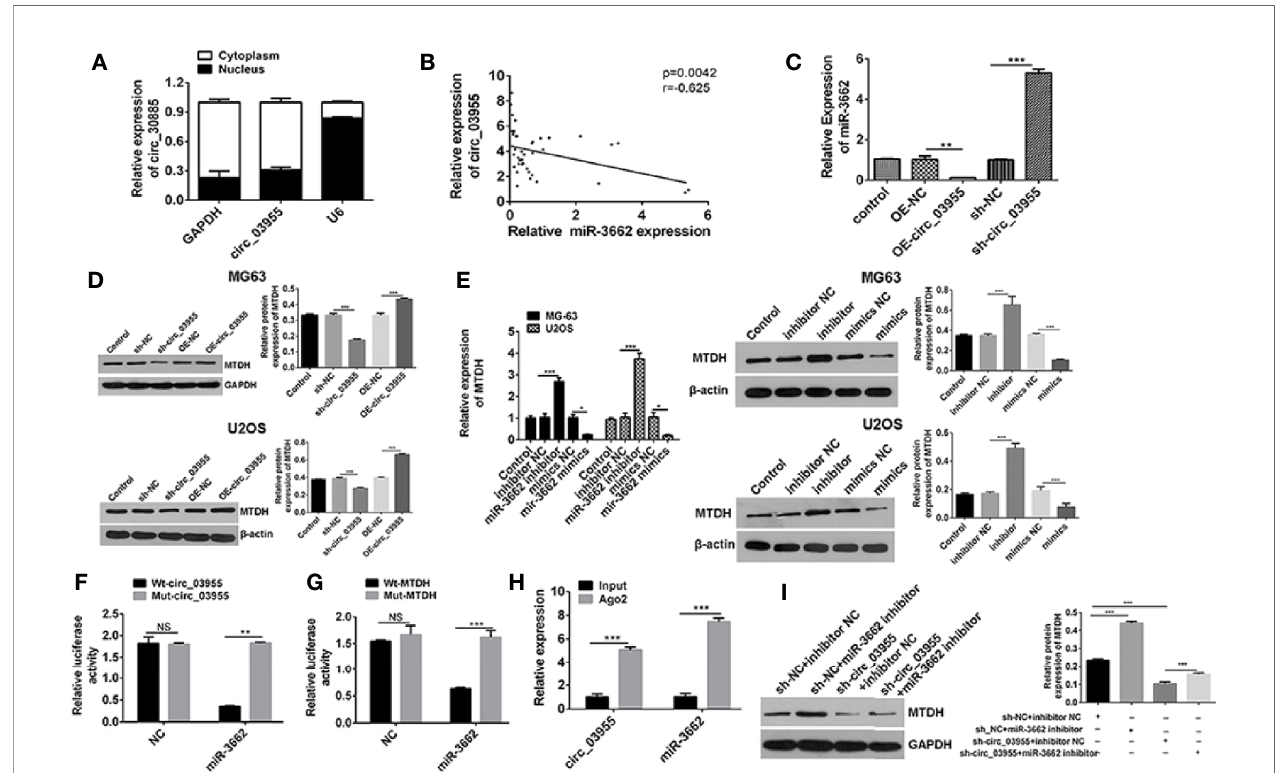
FIGURE 4 | Circ-03955 acts as a ceRNA by sponging miR-3662 and indirectly regulates MTDH expression. (A) The differential expression of circ-03955 in MG-63 cytoplasm and nucleus of osteosarcoma cells veri fi ed by qRT-PCR. (B) Analysis of the correlation between circ-03955 and miR-3662 expression in osteosarcoma. (C) qRT-PCR was used to detect the effect of OE-circ-03955 and sh-circ-03955 on the expression of miR-3662 in osteosarcoma MG-63 cells 48 hours after transfection. (D) Western blotting was used to detect the effects of OE-circ-03955 and sh-circ-03955 on the expression of MTDH protein in osteosarcoma cells MG- 63 and U2OS at 48 hours after transfection. (E) The expression of MTDH in osteosarcoma MG-63 and U2OS was detected by qRT-PCR after 48 hours of transfection. Western blotting was used to detect the expression of MTDH protein in osteosarcoma MG-63 and U2OS at 48 hours after transfection. (F) The binding relationship between circ-03955 and miR-3662 was detected by the dual luciferase reporting system. (G) The binding relationship between miR-3662 and MTDH was detected by the dual luciferase reporting system. (H) Ago2-RIP assays were used to detect the relationship between circ-03955 and miR-3662. (I) Western blot assays were used to verify that circ-03955 reverses the inhibitory effect of miR-3662 on MTDH. Data are presented as the mean ± standard deviation of three independent experiments, NS, not signi fi cant, * p < 0.05, ** p < 0.01, *** p <